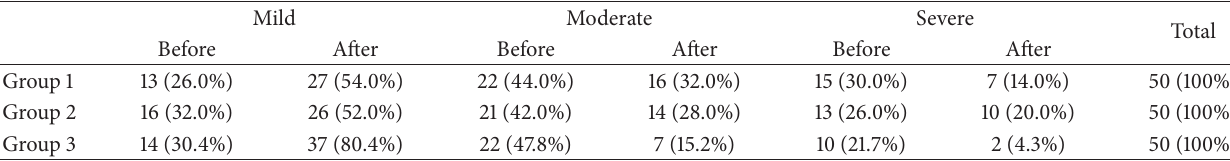
Table 2: Classification of steatosis in NAFLD before and after